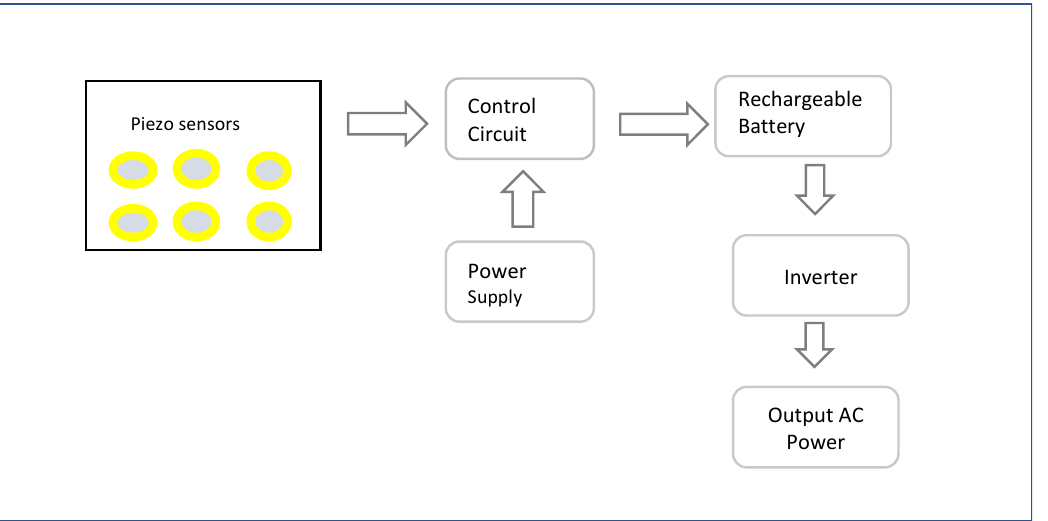
Figure 6. Flow of energy generation from Piezo electric plates. Adapted with permission from Ref. [138]. Copyright 2021, IEEE.